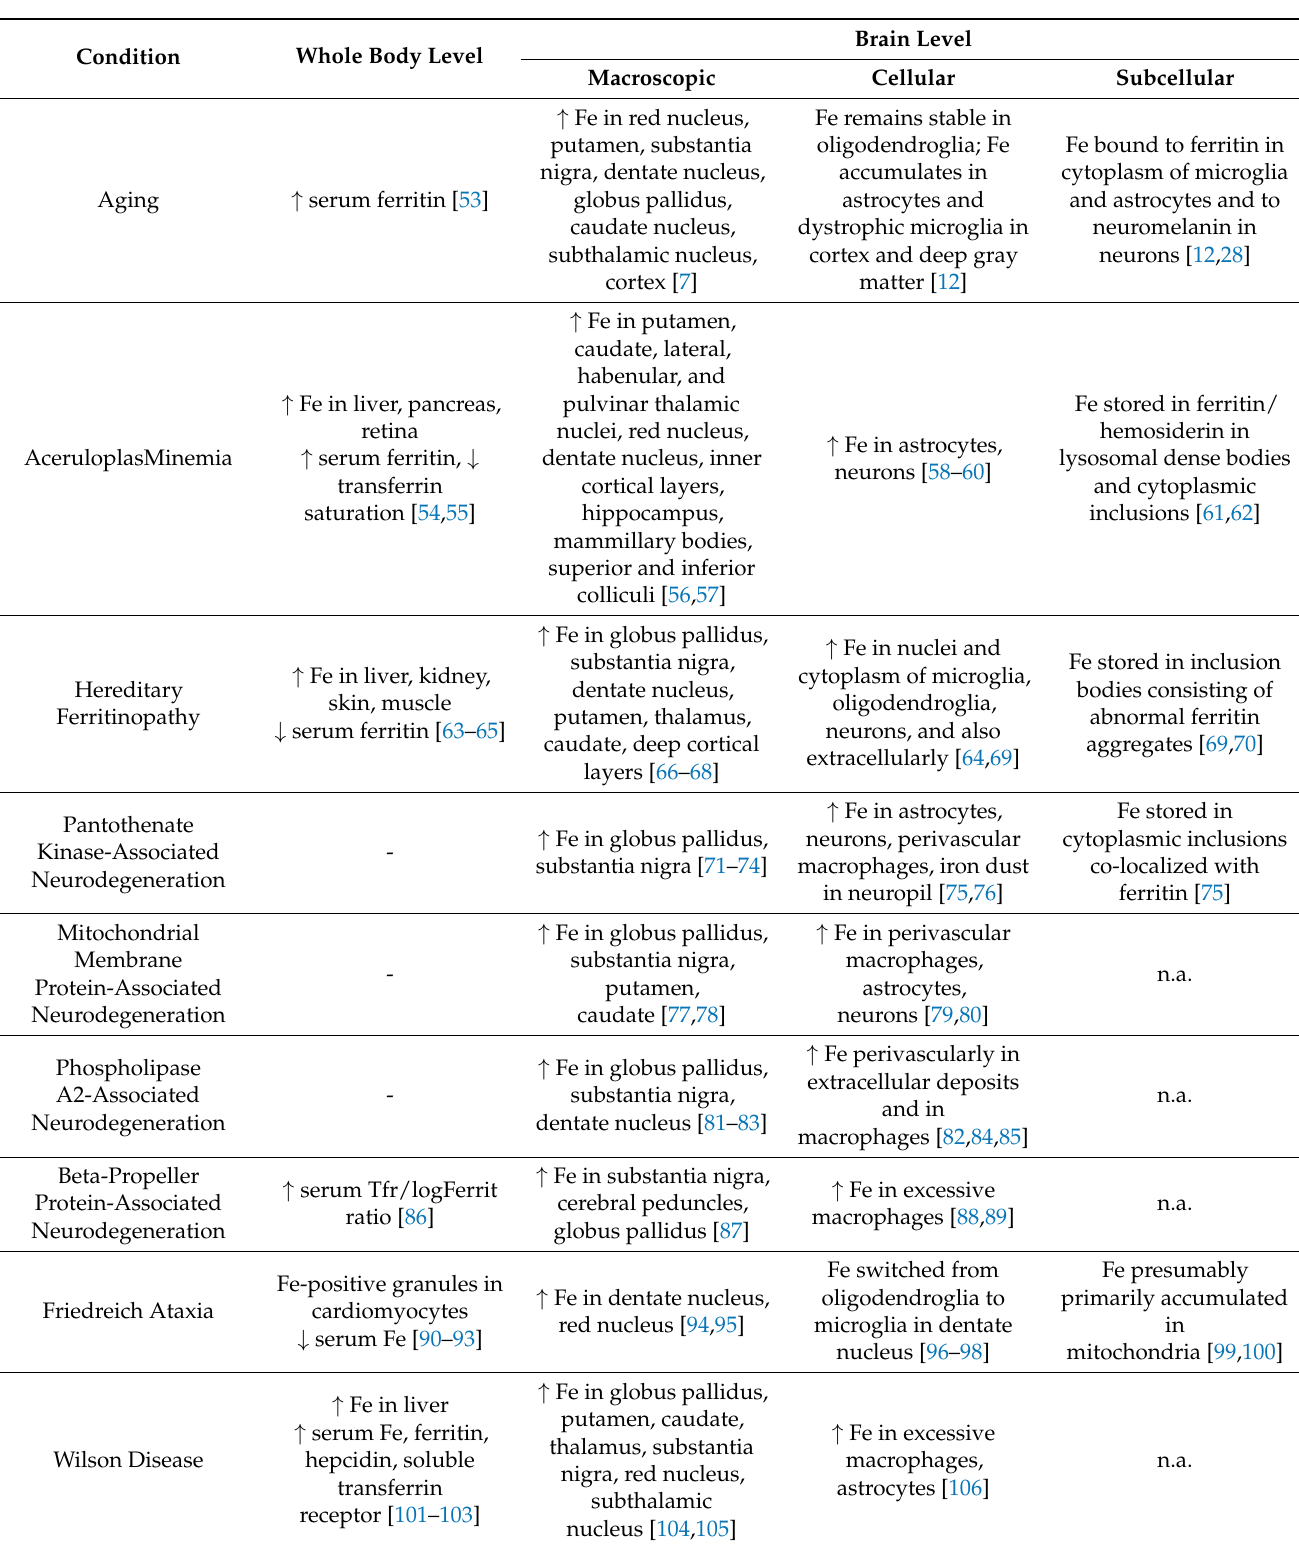
Table 1. Patterns of iron metabolism disturbances and accumulation in aging and neurodegenera- tive